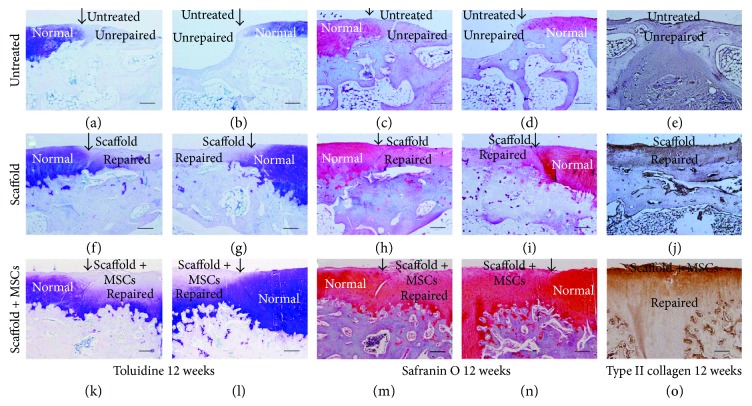
Toluidine blue, safranin O, and immunohistochemical staining of the collagen type II content of repaired cartilage at 12 weeks postimplantation (a–o). (a) and (e) The defect in the untreated group was partially filled with fibrotic tissue but did not stain for cartilage-specific matrix. (f) and (j) The defect region was filled with repaired cartilage, with light staining for cartilage-specific matrix. (k) and (o) The cartilage defect was filled with regenerated cartilage, and the deep regenerated area stained strongly for cartilage-specific matrix (bars: 50 μm).